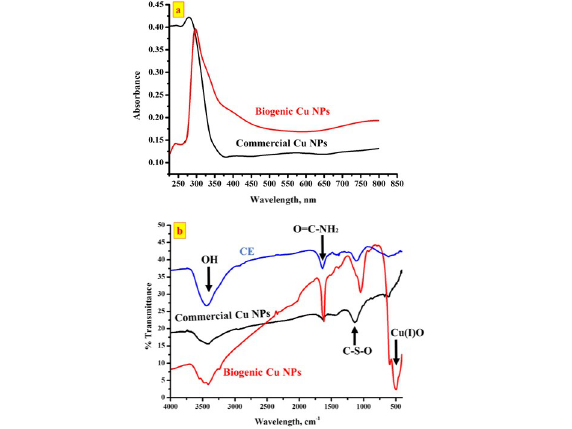
Fig 3. UV-Vis spectra of the biogenic and commercial Cu NPs (a), together with the FTIR spectra of the CE, biogenic and commercial Cu NPs (b).